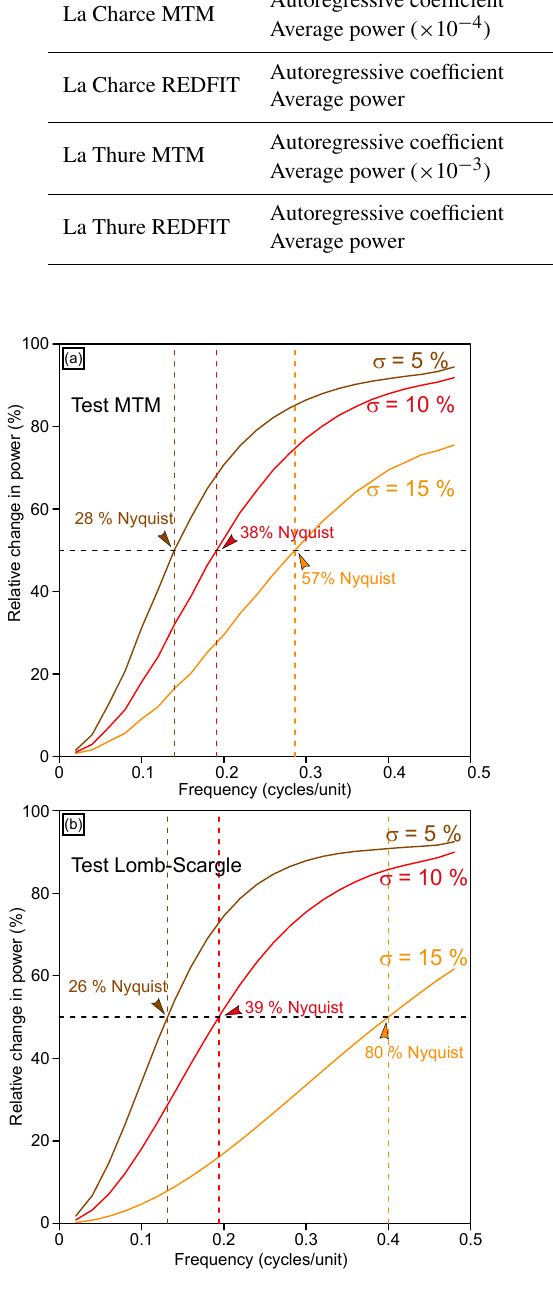
Figure 4. Relative change in power in the (a) 2 π -MTM spectra and (b) Lomb–Scargle spectra after applying the gamma-law simu- lations of distortion of the time series. The arrows indicate at which frequency (relatively to the Nyquist frequency) the change in power reaches 50%.